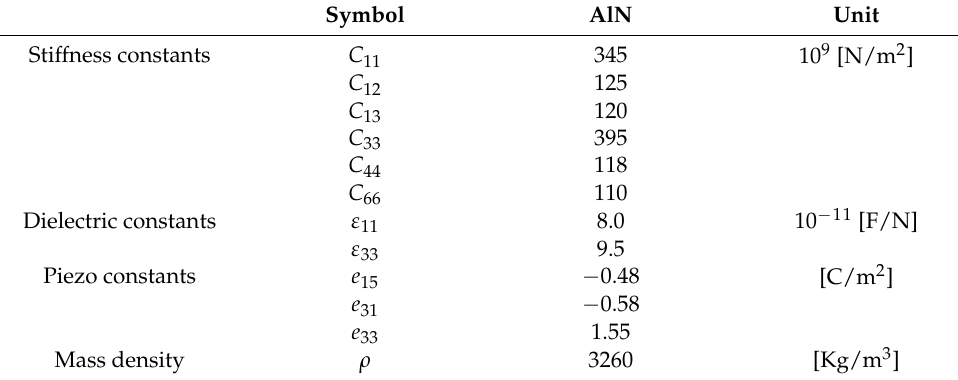
Table 1. AlN physical properties used in this work’s simulations